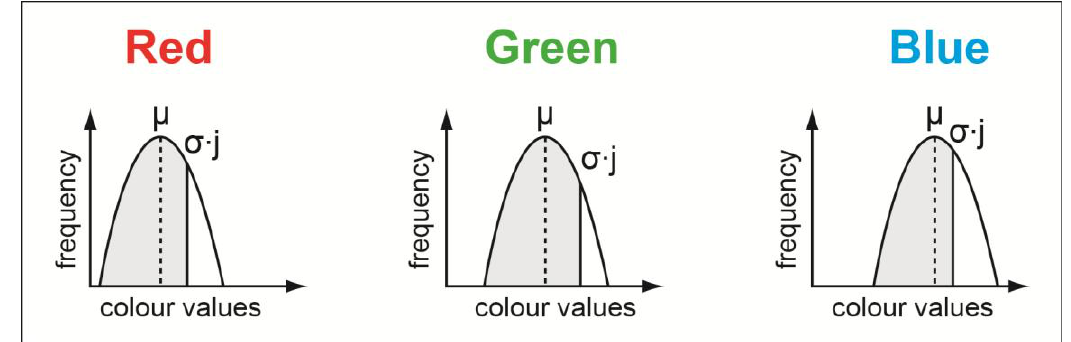
Figure 3. Schematic illustration of setting the dynamic threshold in the distribution of the digital numbers (DNs) of each colour